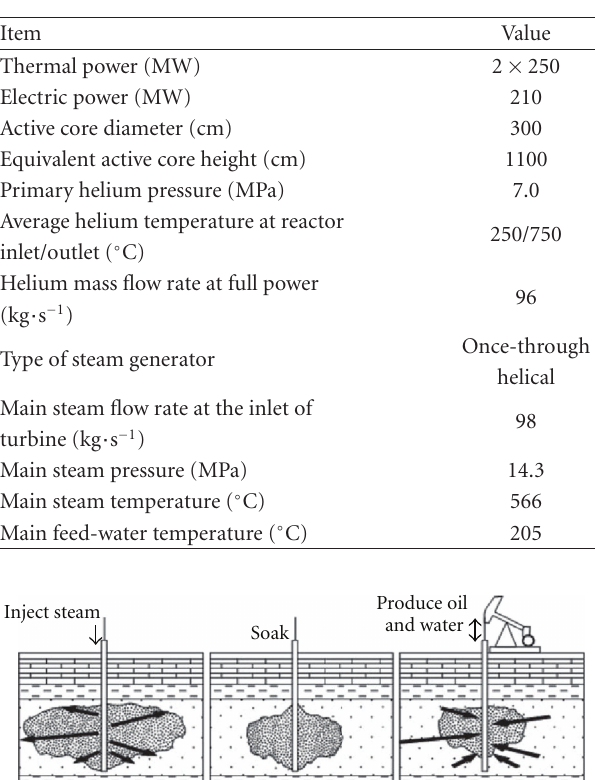
Table 1: Major design parameters of HTR-PM [17].